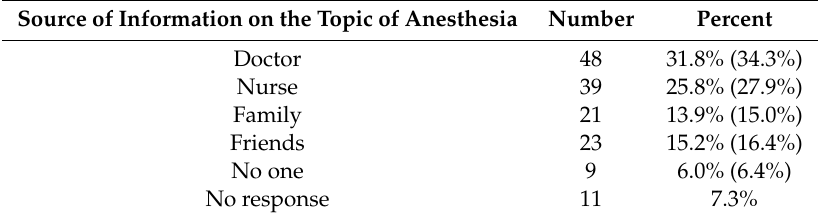
Table 4. Source of information on surgical anesthesia.